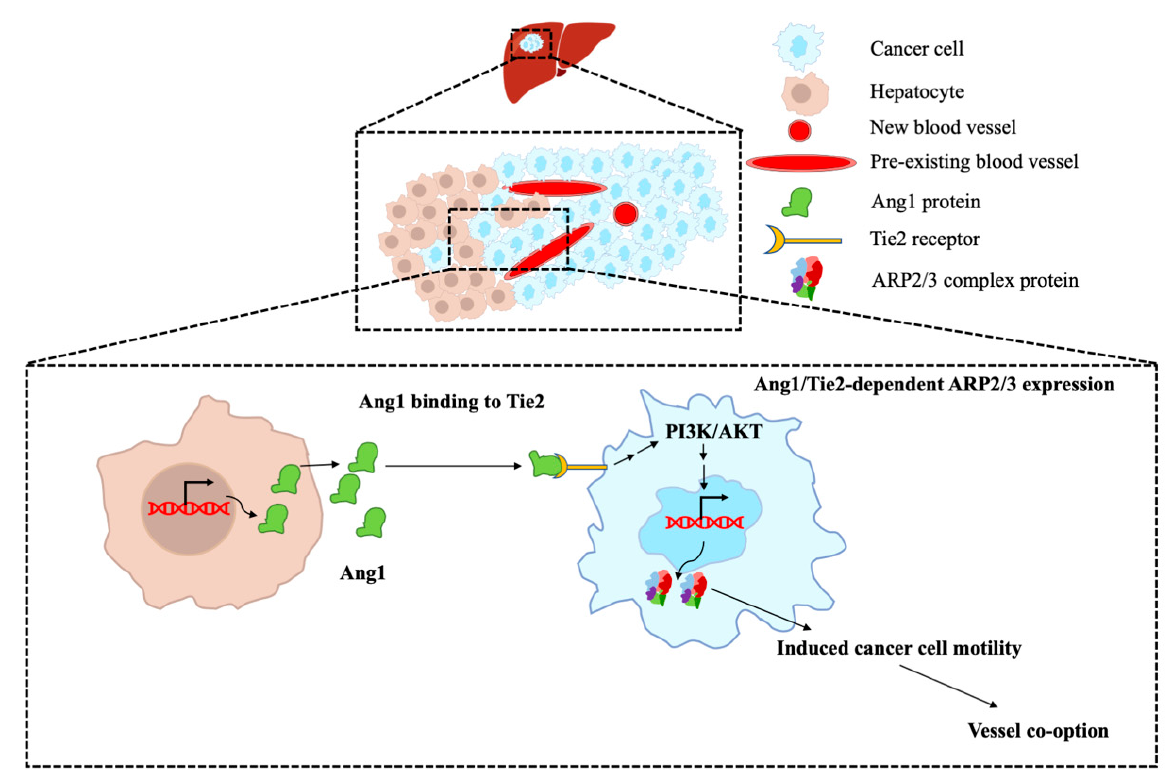
Figure 6. The molecular mechanism of Ang1 function in vessel co-opting CRCLM lesions. Schematic representation of key findings in the current study. The hepatocytes of vessel co-opting lesions express high levels of Ang1. The secreted Ang1 by hepatocytes interacts with the cancer cells through Tie2, which activates PI3K/AKT followed by ARP2/3 expression, respectively. Upregulation in ARP2/3 expression increases cancer cell motility and allows them to infiltrate the liver tissue to obtain blood supply by hijacking the pre-existing vessels (vessel co-option). ern blots of Figure 1; Figure S2: Original uncropped Western blots of Figure 3; Figure S3: Original uncropped Western blots of Figure 4; Figure S4: Original uncropped Western blots of Figure 5; Table S1: The intensity ratio of Western blot bands; Table S2: The positivity of the IHC images.